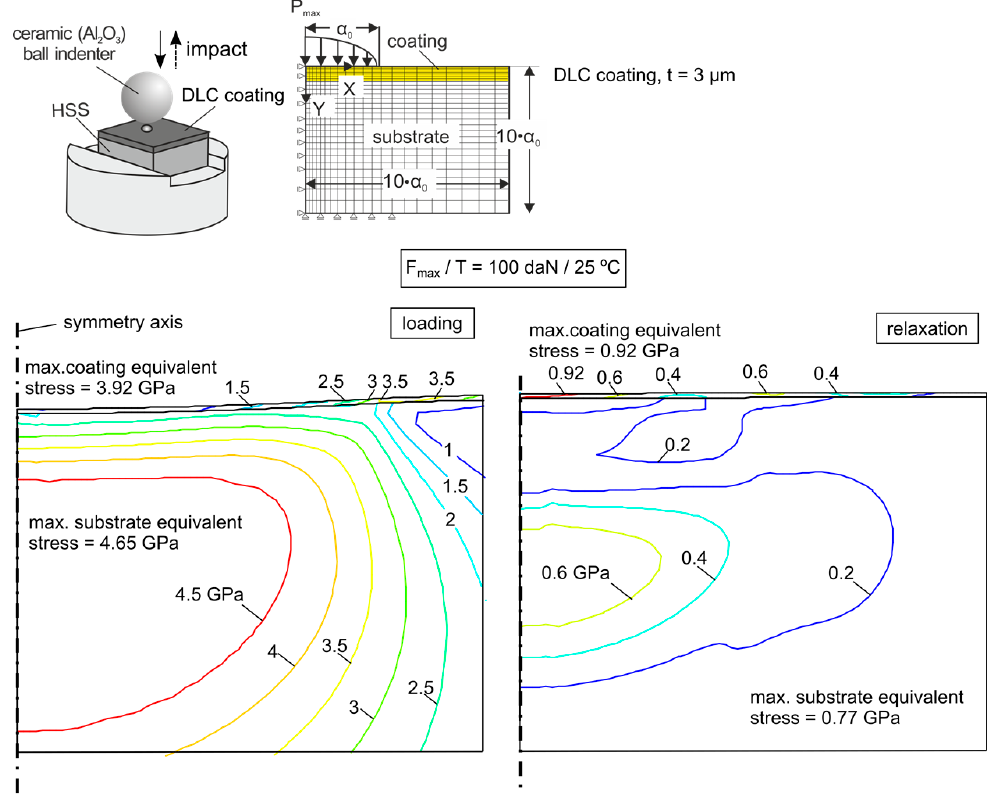
Figure 15. FEM supported calculation of the developed maximum and remaining stress fields in the coating and its substrate during the impact test loading and relaxation phases.